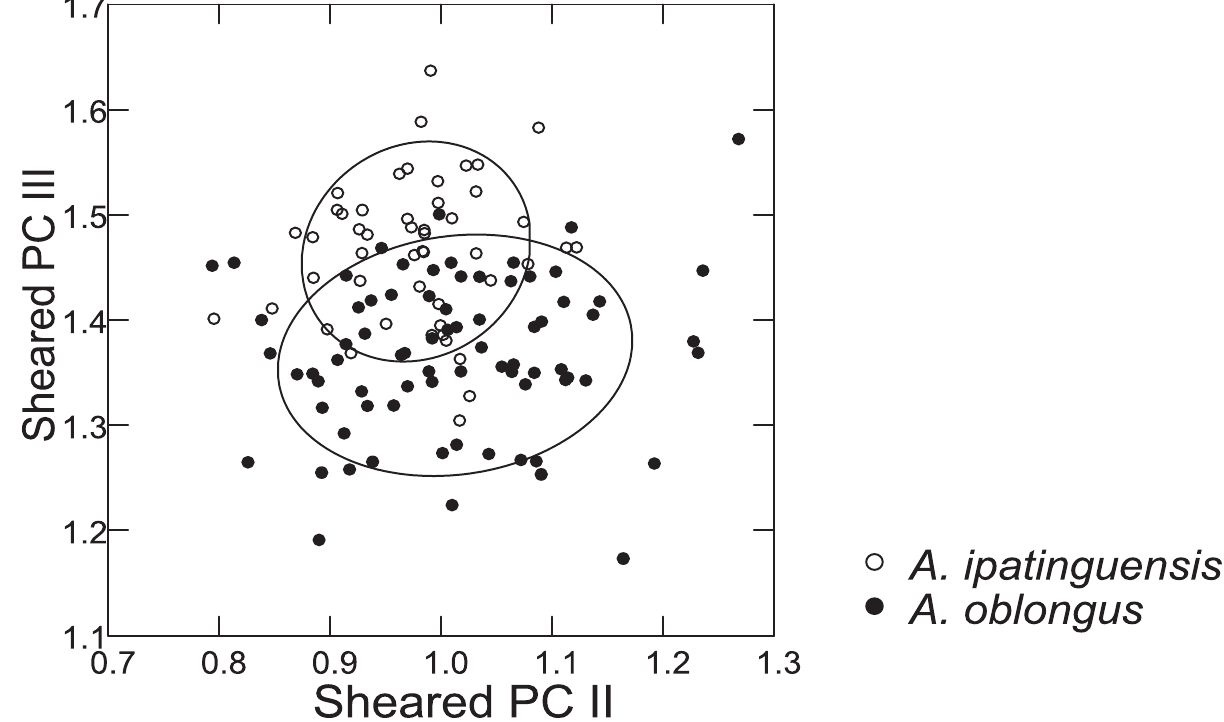
Fig 6. Plot of scores of PC II on PC III from PCA of 13 distance measurements from pooled samples of Australoheros ipatinguensis and A . oblongus